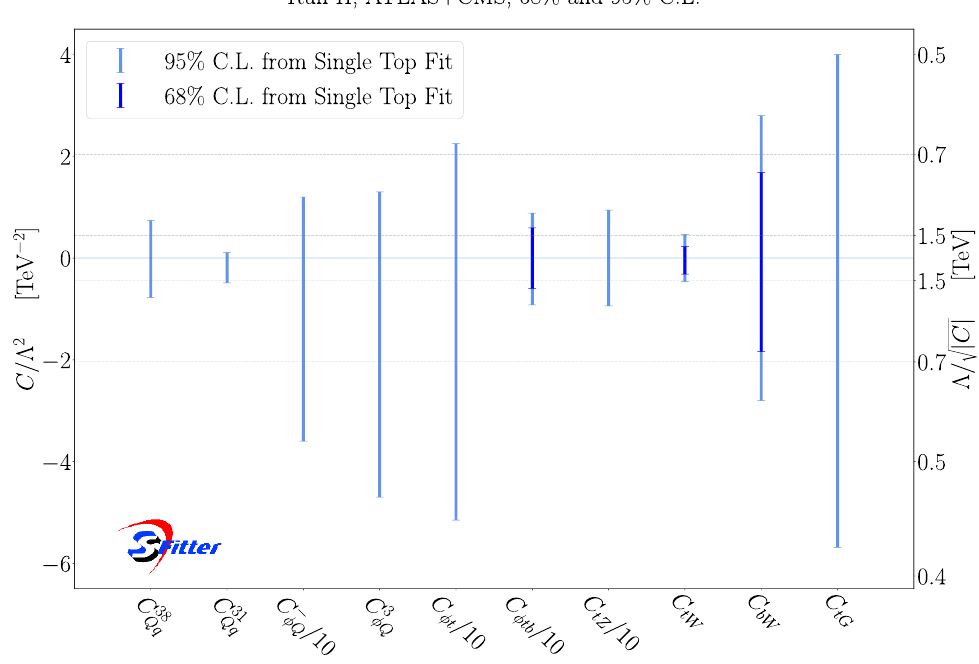
Figure 11 . 95% and 68% CL bounds for the global (cid:12)t to the single top data set from table 6. Whenever the 68% CL is not shown it falls into the (cid:13)at pro(cid:12)le likelihood regime re(cid:13)ecting dominant theoretical